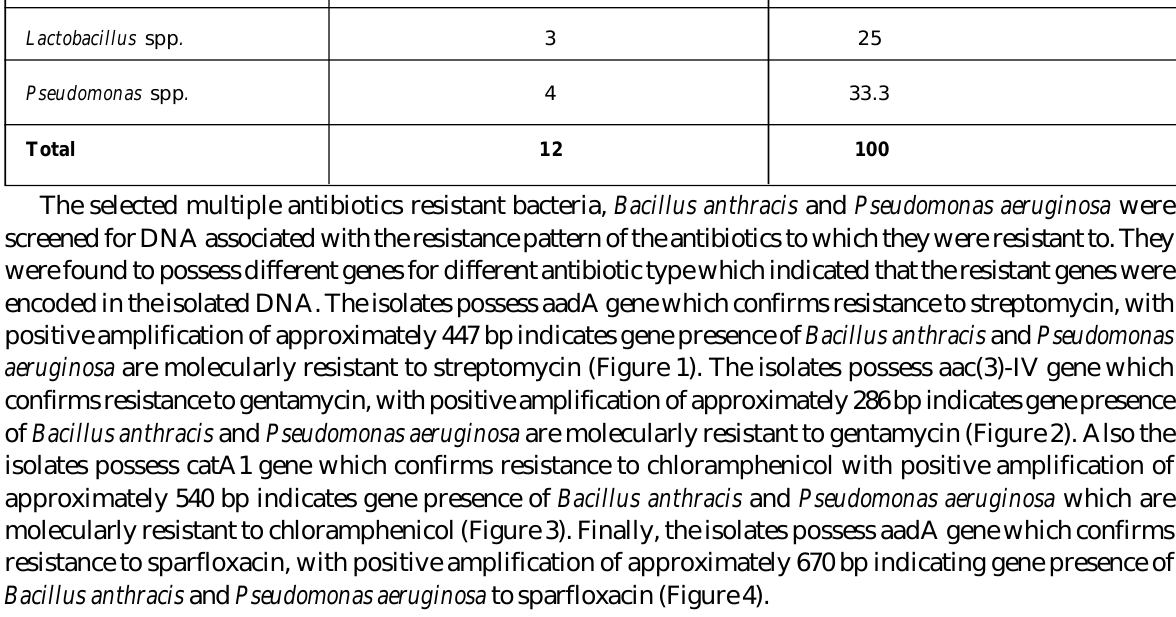
Table 4: Percentage distribution of facultative anaerobic bacterial isolates Organisms Number Frequency (%) Serratia spp. 1 8.3 Bacillus spp. E.coli Lactobacillus spp .